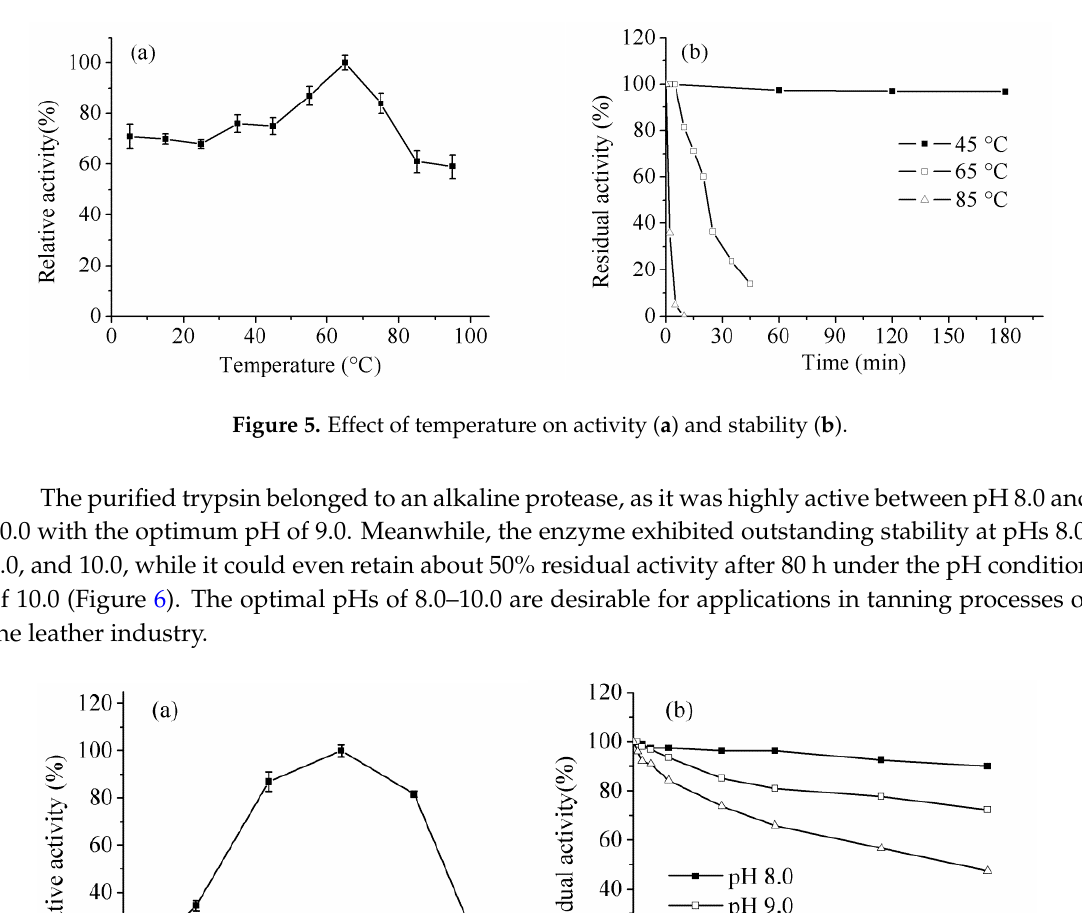
Table 3. Results of trypsin purification procedures. Purification Step